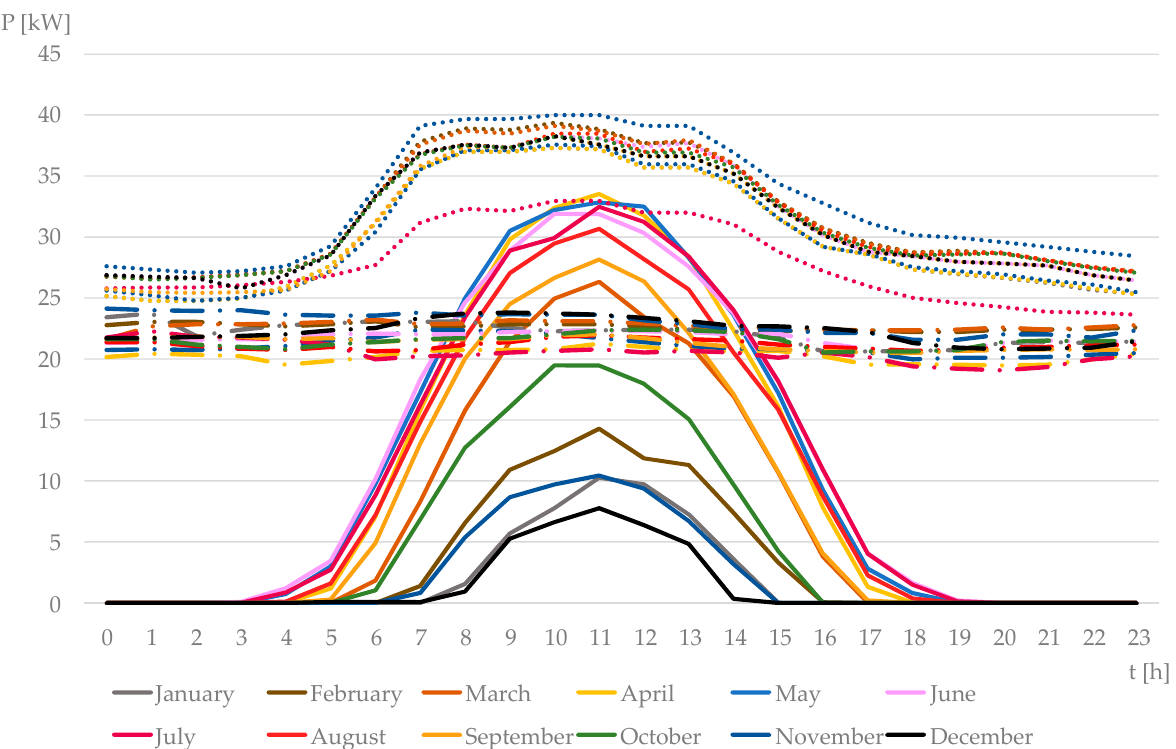
Figure 2. Joint representation of PV generation (solid lines), working day (dotted lines) and non-working day consumption (dash-dotted lines), with different colours for each month. Self-elaboration.